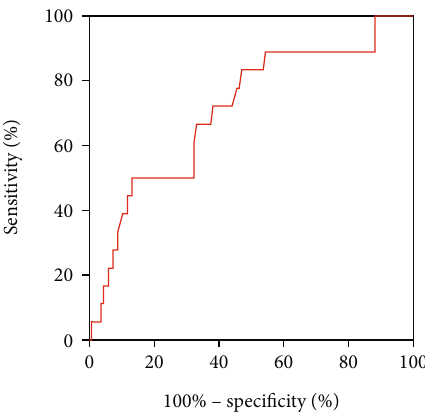
Figure 2: The receiver-operator characteristic analysis of RS duration in lead V2.